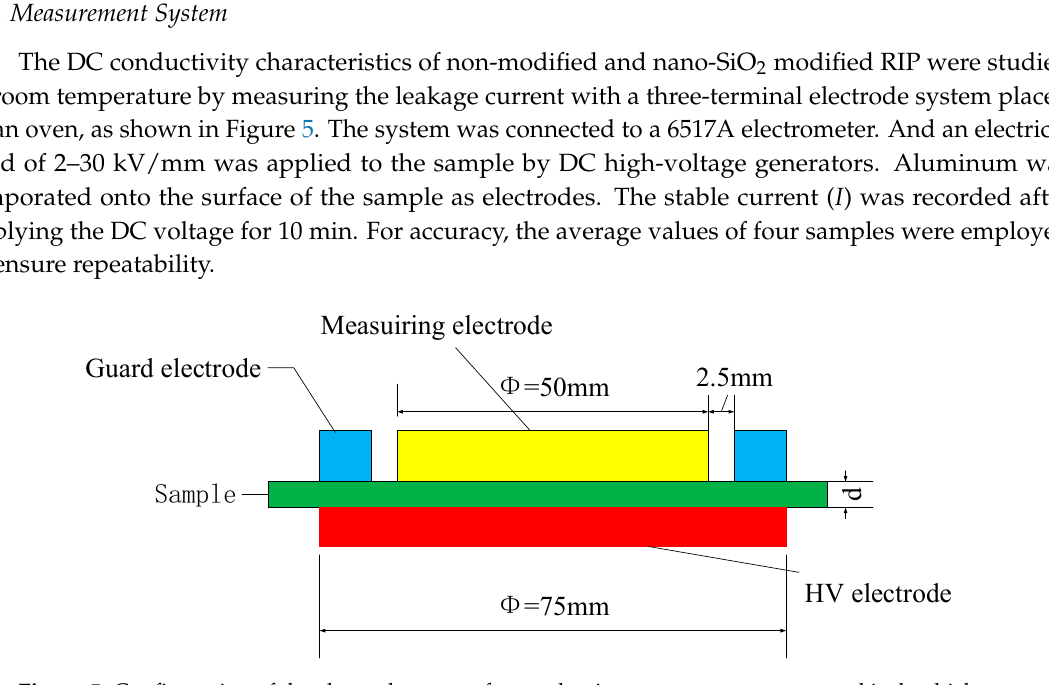
Temperature controller Figure 7. Schematic of thermal simulated current (TSC) measurement system. 0